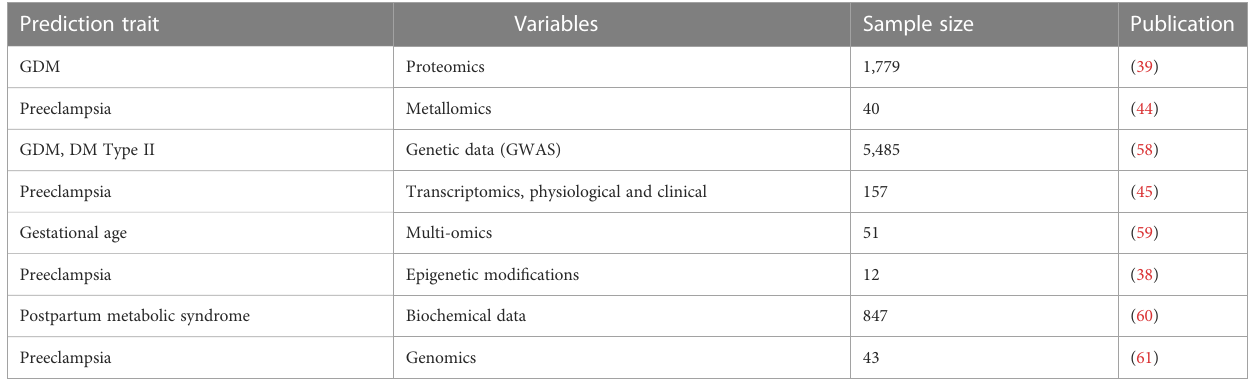
TABLE 1 A representative list of studies on pregnancy complications using omics data. Prediction trait